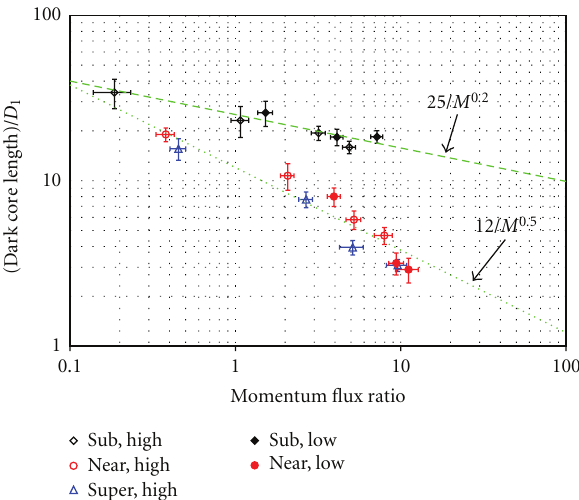
Figure 21: Plots of the dark-core length versus momentum flux ratio for a coaxial injector. Liquid nitrogen (inner jet) and gaseous nitrogen (outer annular jet) injected into chamber filled with gaseous nitrogen. The diamond, circle, and up-triangle symbols represent sub-, near-, and supercritical chamber pressure, respec- tively. The hollow symbols are at a “high” outer-jet temperature ( ∼ 190K) and solid symbols are at a “low” outer-jet temperature ( ∼ 140K). The dashed line is 25 /M 0 . 2 and the dotted line is 12 /M 0 . 5 . Davis and Chehroudi [43,